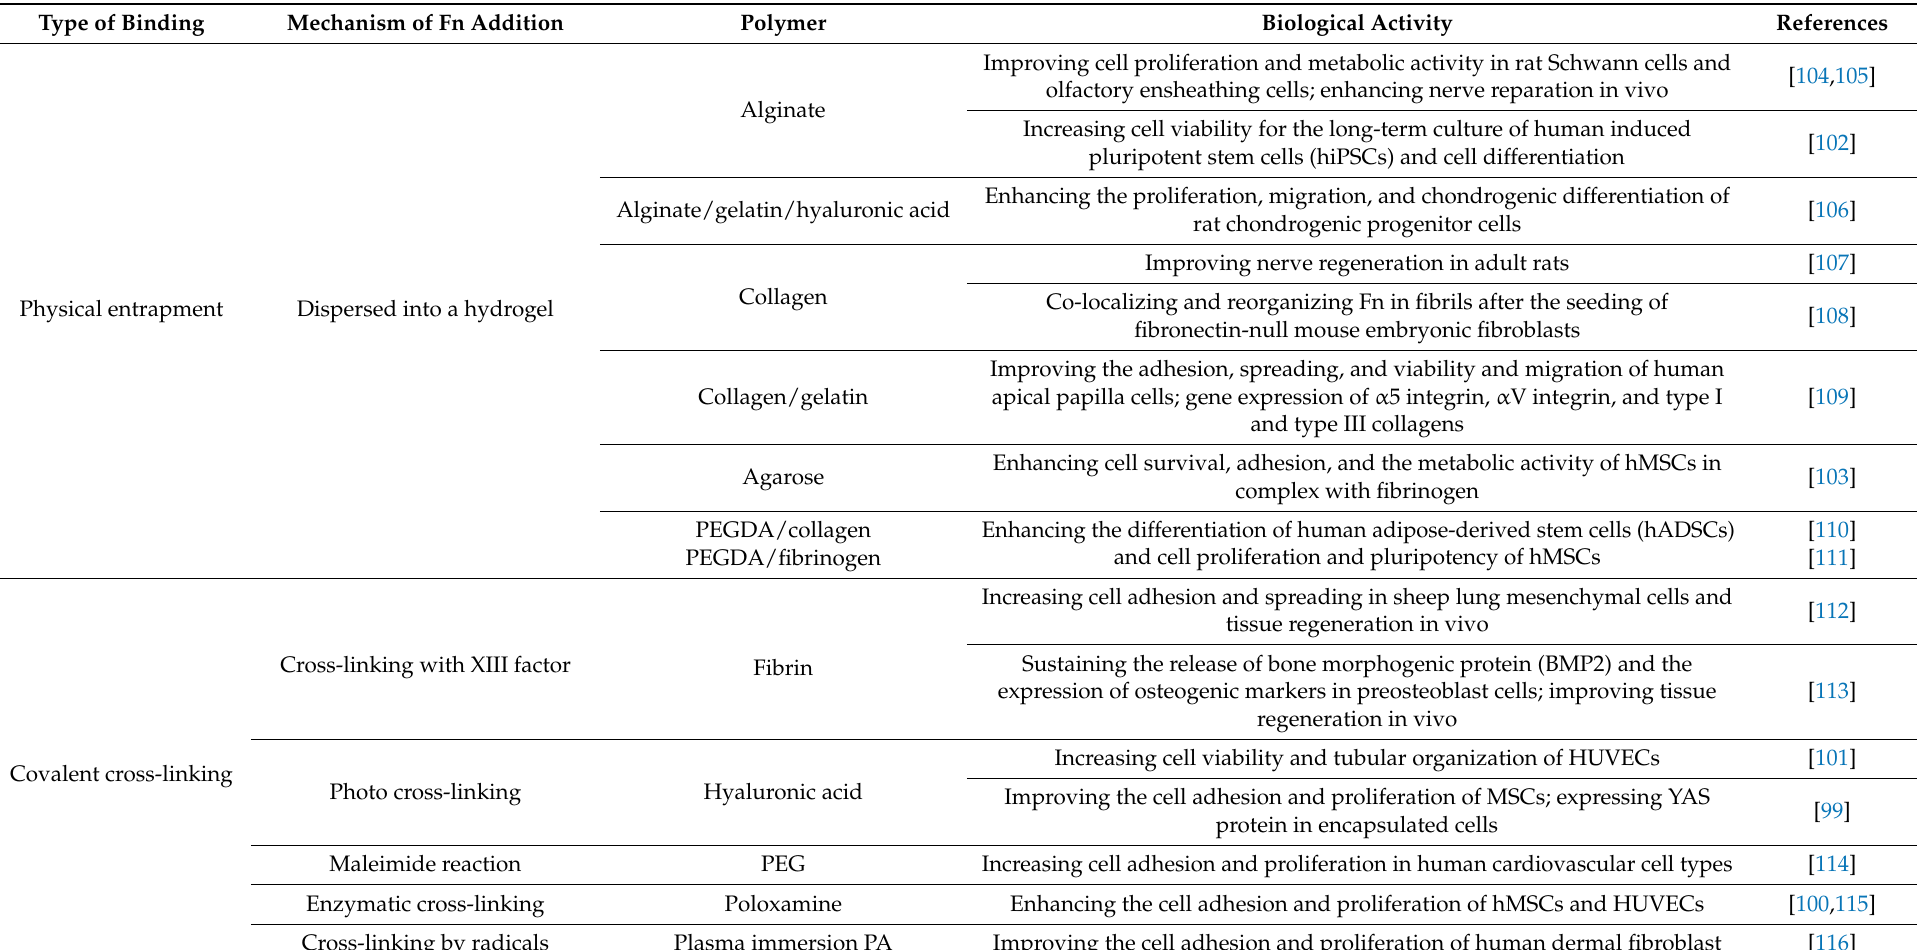
Table 2. Fn in a three-dimensional (3D) matrix using different strategies and related biological